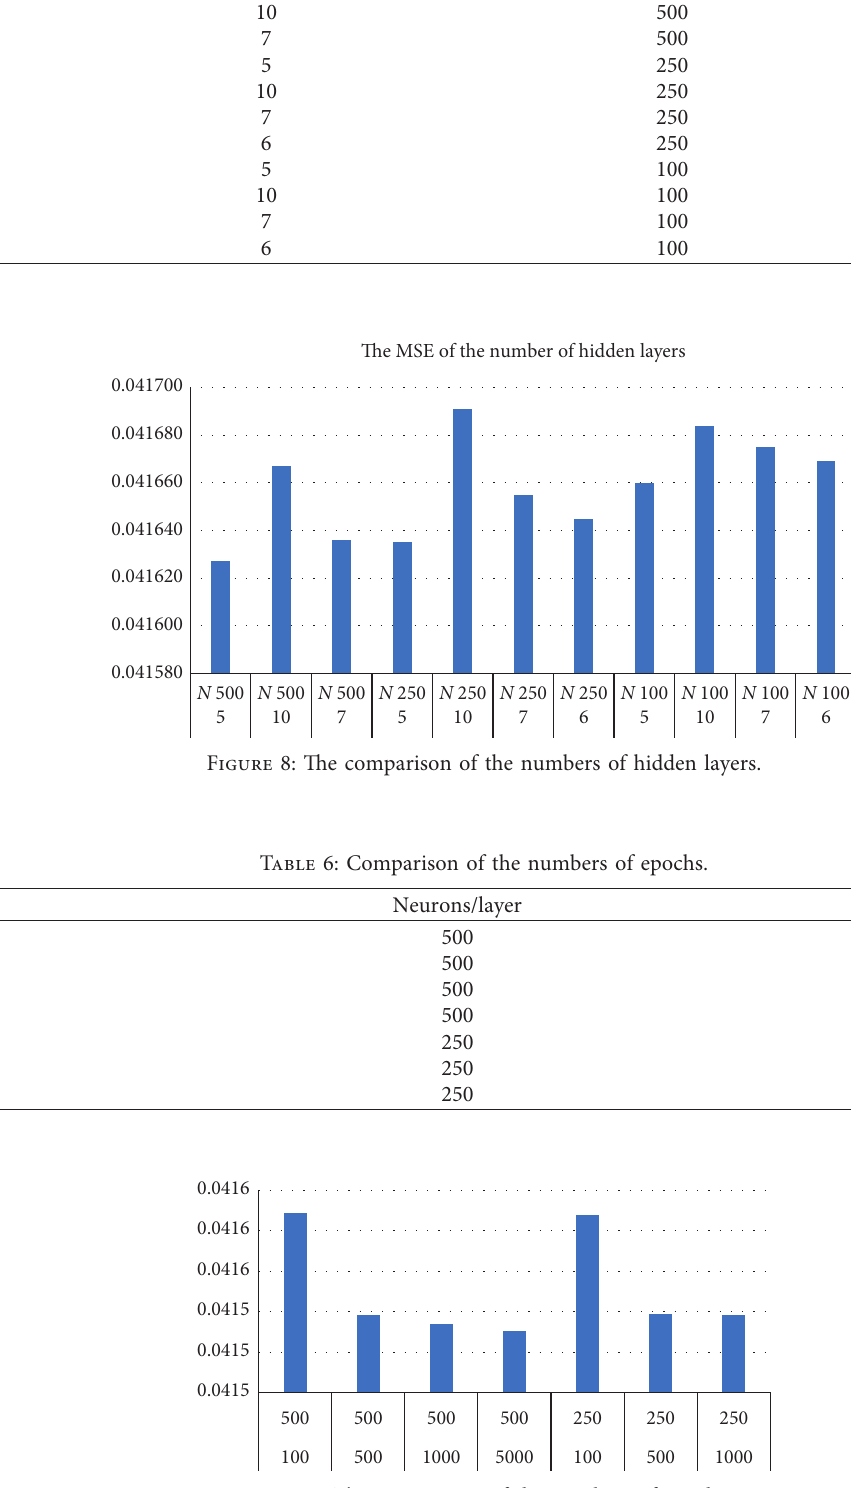
Figure 9: The comparison of the numbers of